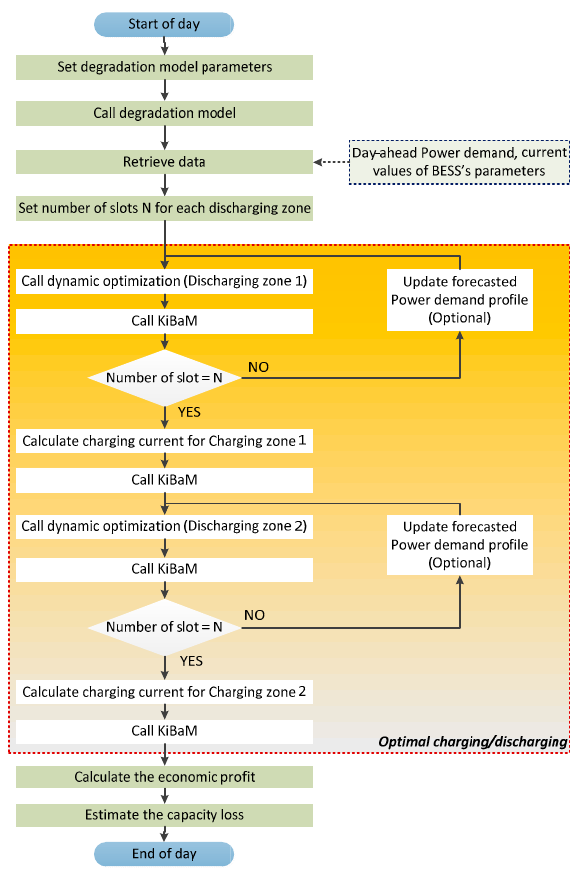
Figure 7. EMS at autumn/winter ToU tariff.